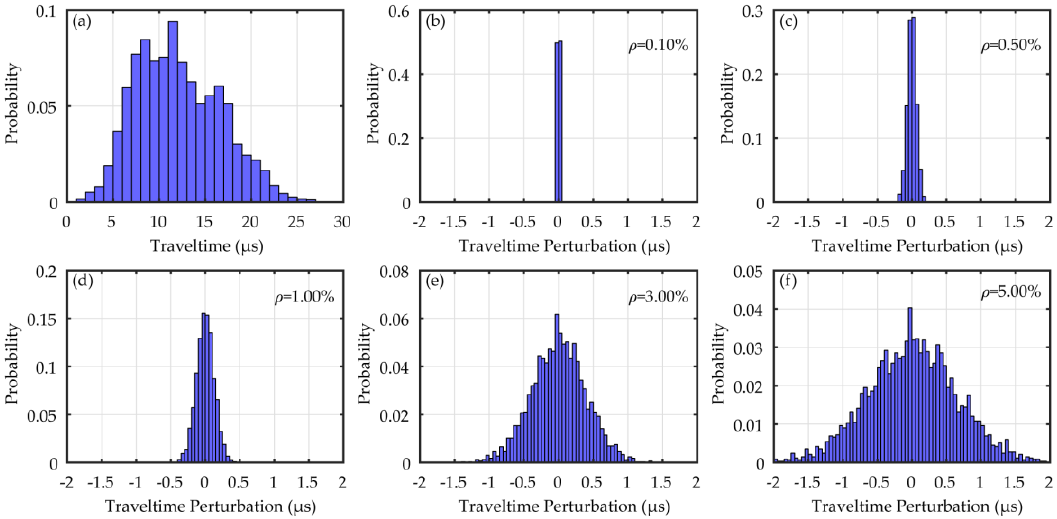
Figure 9. ( a ) the histogram of travel time calculated by FMM; ( b – f ) the histograms of the perturbation for 0.1%, 0.5%, 1%, 3%, and 5% noised travel time.